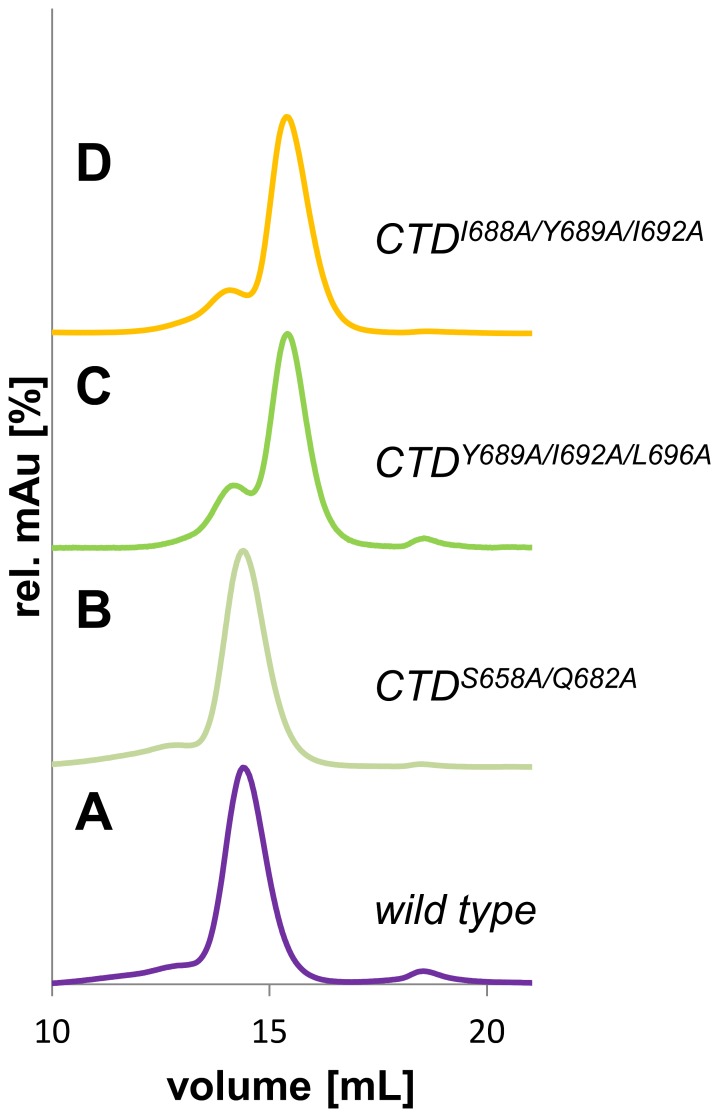
Elution profiles of hHsp90 CTD variants using size exclusion chromatography.Chromatograms for wild type hHsp90 CTD (A), cold spot (B), and hot spot alanine mutants (C and D). Experiments were performed in triplicates on a Superdex SD200 10/300 column in HPLC-buffer (10 mM MES/KOH, 200 mM KCl, 1 mM EDTA, 1% Glycerol) at pH 6 with 110 µL of purified hHsp90 CTD. The molecular weight of hHsp90 CTD variants was calculated based on the slope of the calibration curve obtained with standard proteins. The elution peak of the wild type corresponds to a molecular weight of 88±0.5 kDa, indicating an apparent tetrameric complex. The cold spot mutant shows the same elution profile as the wild type protein corresponding to a molecular weight of 88±0.3 kDa. Alanine mutants CTDY689A/I692A/L696A and CTDI688A/Y689A/I692A show a shift to lower molecular weights of 57–58 kDa (57±0.2 kDa for CTDY689A/I692A/L696A and 57±0.4 kDa for CTDI688A/Y689A/I692A). This indicates a smaller protein complex suggesting a weakly associated dimer or closely associated trimer configuration.